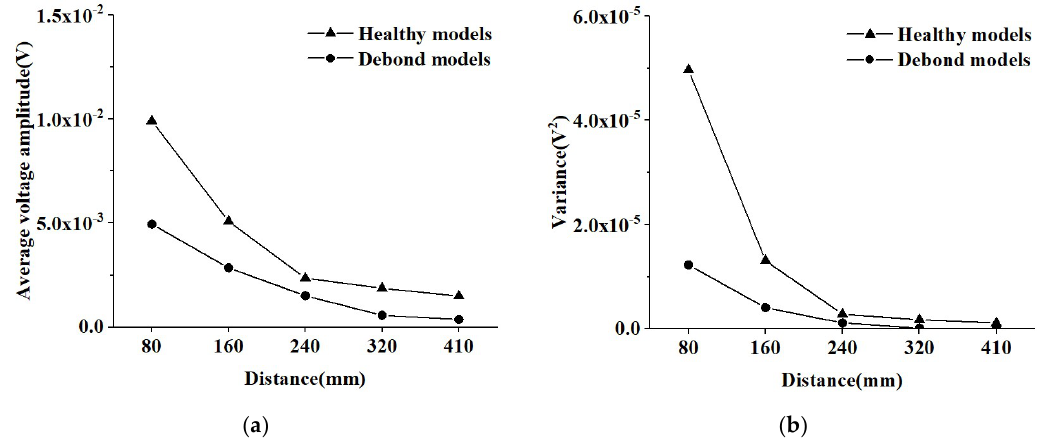
Figure 15. Comparison of average voltage amplitude and variance in the responses of PZT sensors shown in Figure 14 for the three CMFEMs and three CHFEMs with and without debond defects. ( a ) Average voltage amplitude; ( b ) Variance.